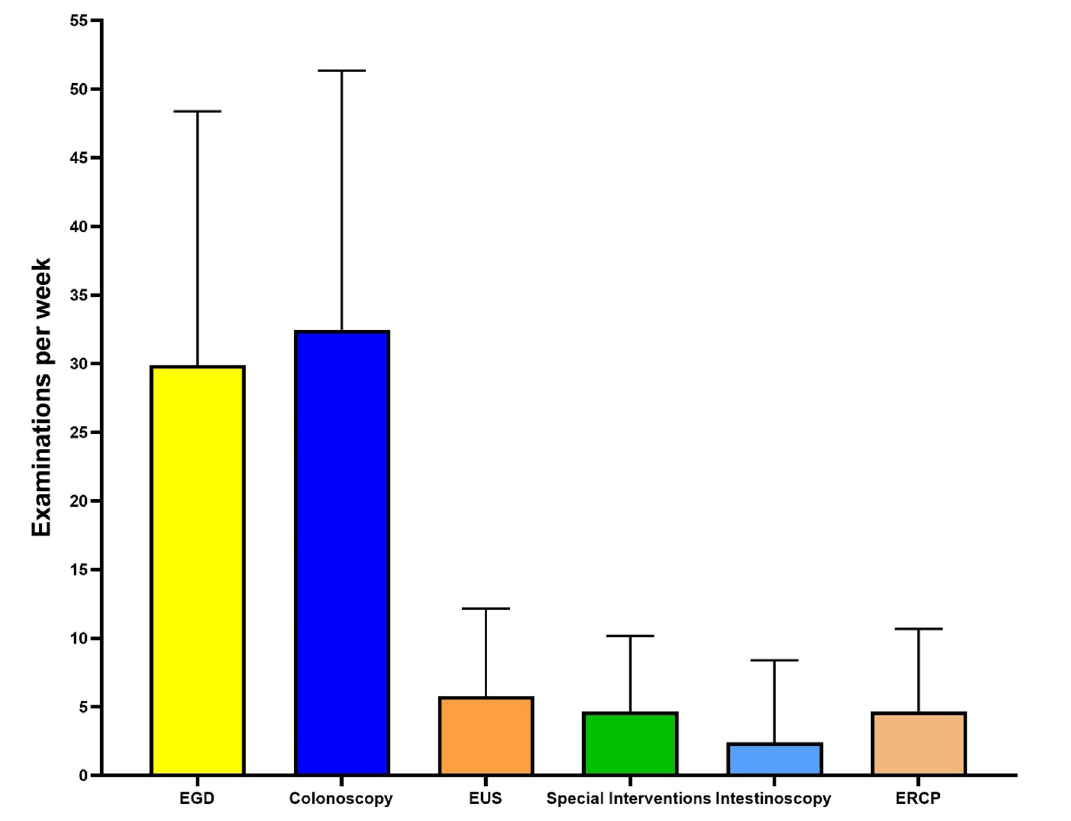
Figure 1. Number of endoscopic procedures per week (medium and maximum) of German endoscopists by examination category. Special interventions included ESD, EMR, POEM and FTR. EGD Oesophagogastroduodenoscopy, ERCP endoscopic retrograde holangiopancreatography, EUS endoscopic ultrasound, ESD endoscopic submucosal dissection, EMR endoscopic mucosal resection, POEM peroral endoscopic myotomy, FTR full-thickness